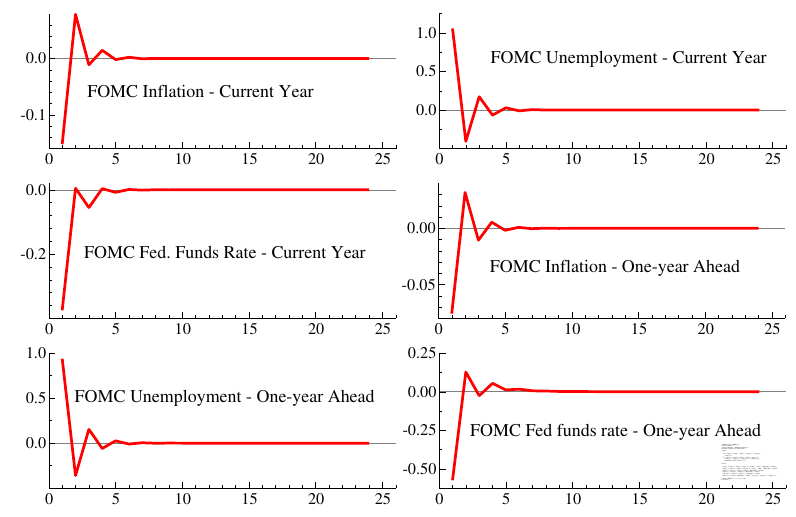
Figure 14. Impulse Responses to a one-percent unemployment revision FIML.